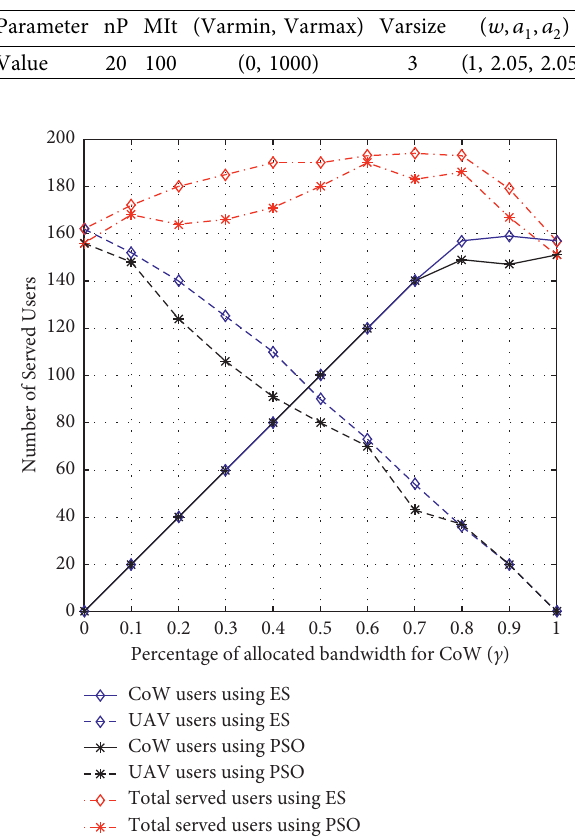
Figure 2: Number of served users using PSO and ES algorithms when the priority is given to the CoW at the